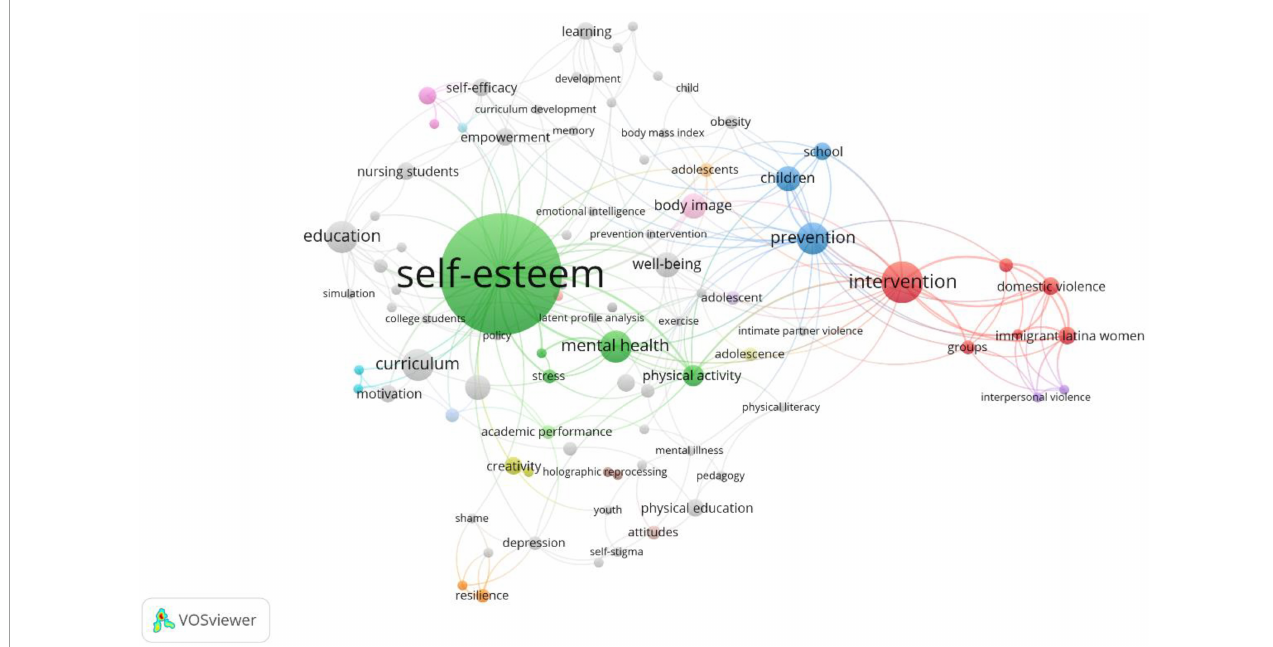
FIGURE6 Co-occurrence networks of research themes based on author keywords.